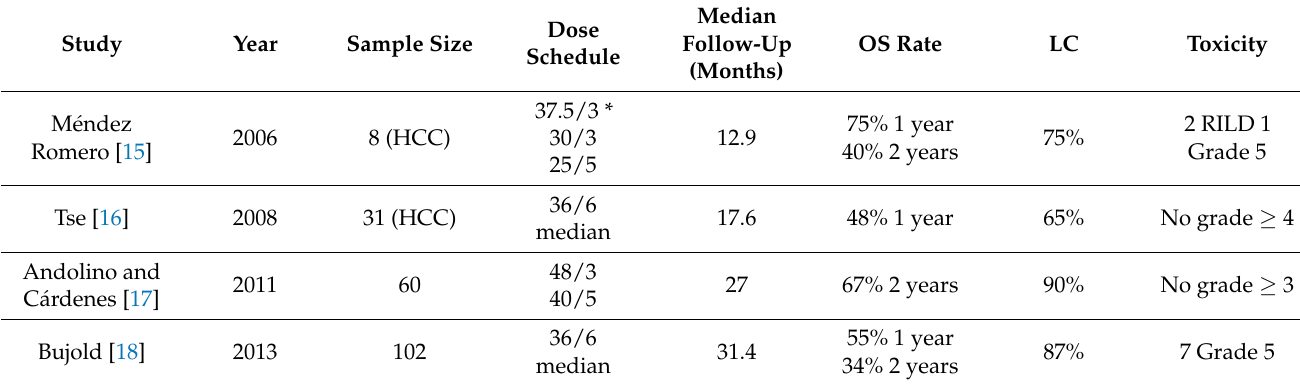
Table 2. Initial dose finding trials of SBRT for HCC.